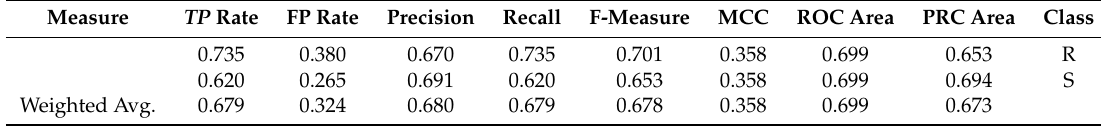
Table 9. Detailed accuracy by class of RIPPER (10-fold cross-validation).